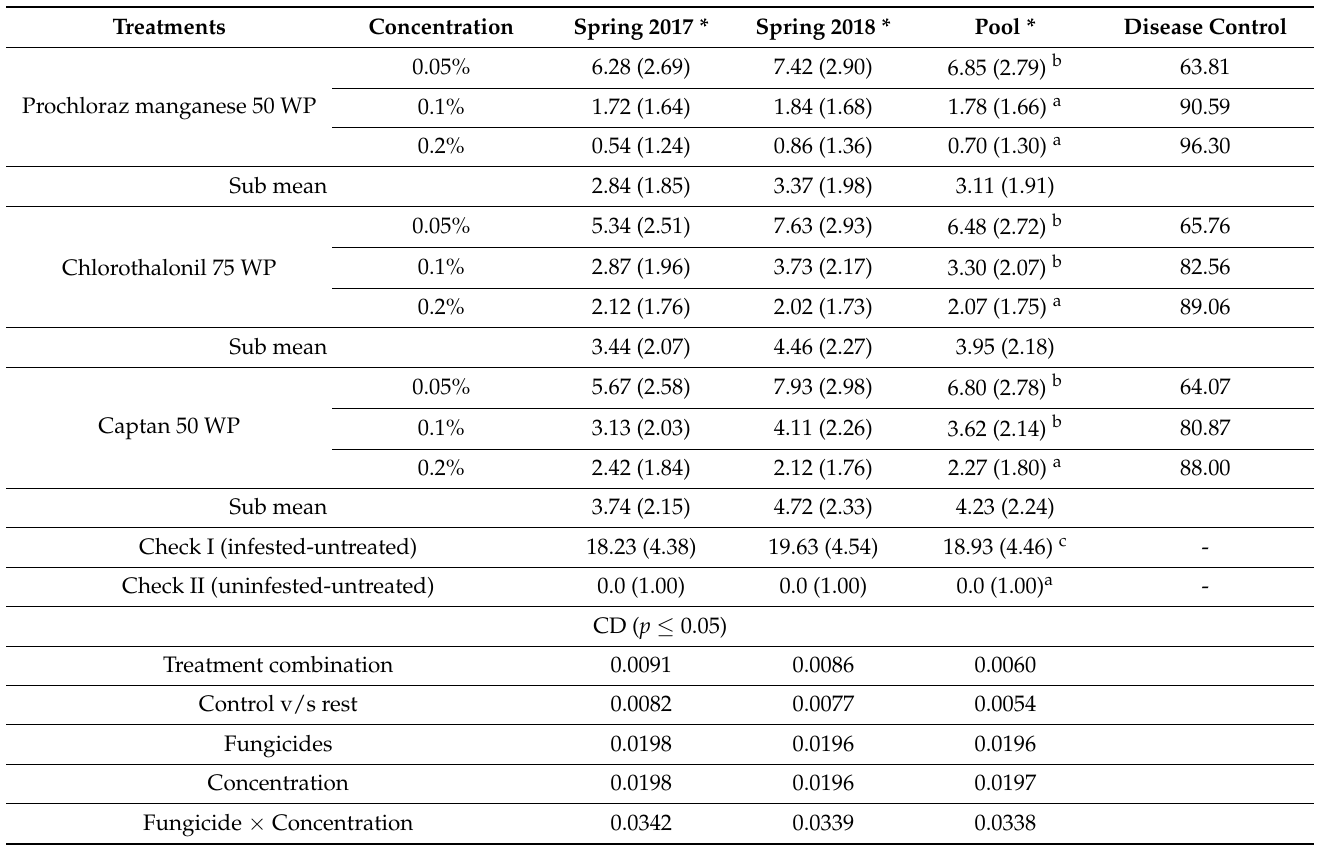
Figure 3. Comparative bar chart ( left ) and boxplots ( right ) designate the effect of non-systemic fungi toxicants under in vitro conditions on host A. bisporus mycelium. Table 4. Impact of non-systemic fungitoxicants in casing on percent intensity of green mold disease of button